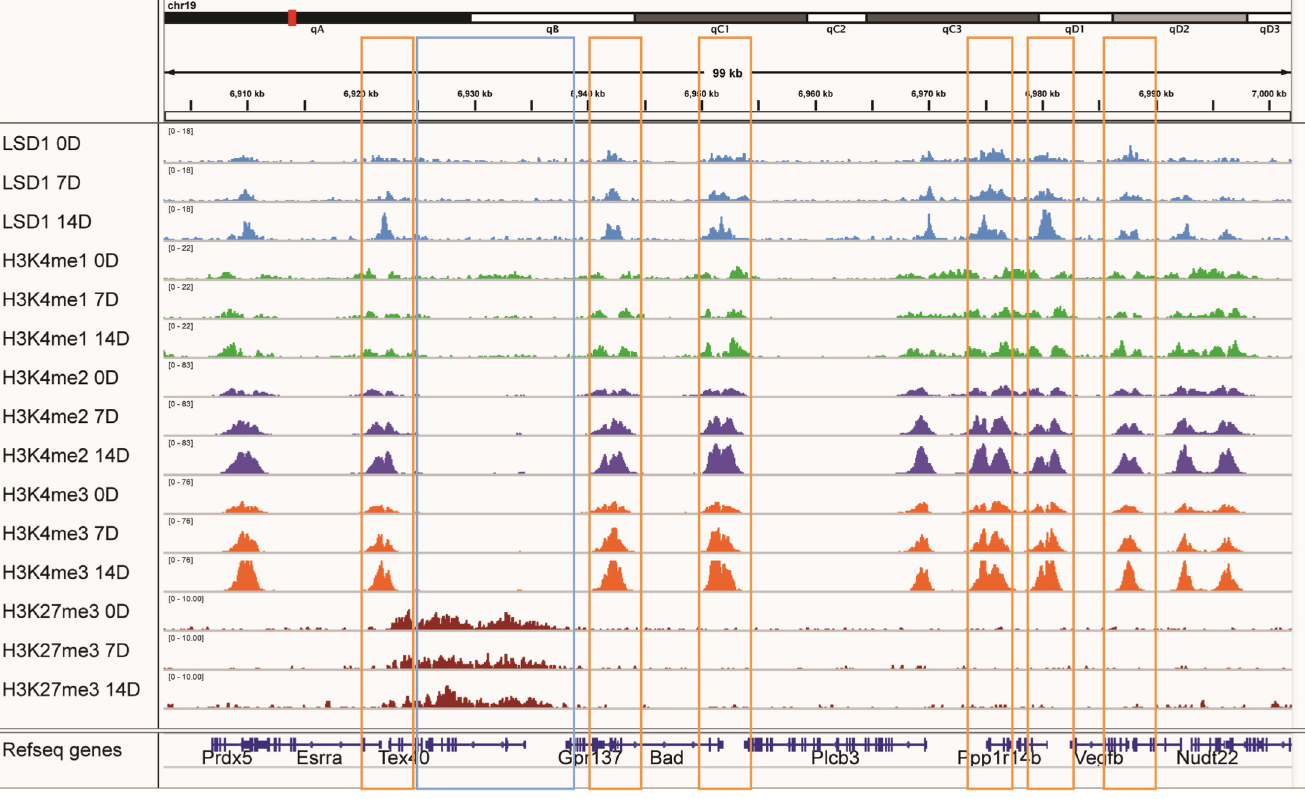
PLOS ONE | https://doi.org/10.1371/journal.pone.0265027 March 7,